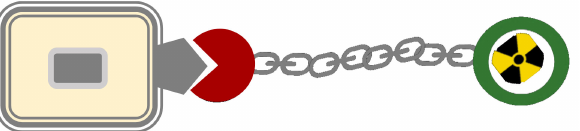
Figure 1. Schematic representation of peptide receptor radionuclide with radiolabeled somatostatin analogues (PRRT) therapeutic model. This is based on the existence of a target, overexpressing SST-Rs and a radiopharmaceutical, consisting of peptide which have a high affinity for the SST-Rs expressed by the target, an adequate radioactive isotope and a chelator able to stable bond the radionuclide.